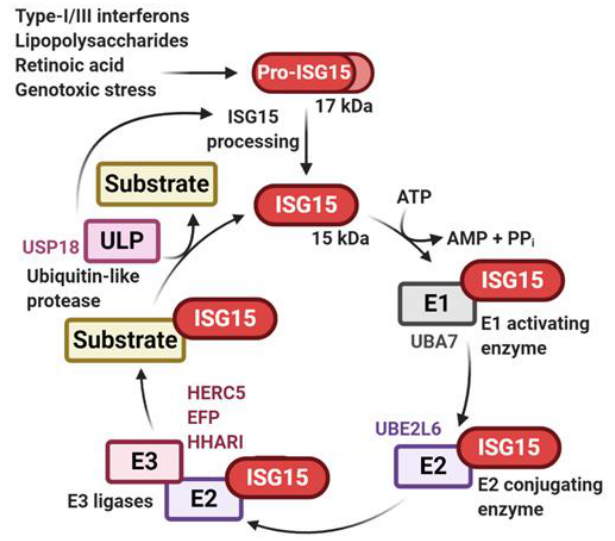
Figure 2. ISG15 conjugation cascade. Expression of ISGylation components is induced by different stimuli as indicated. After processing into its mature form, ISG15 can be conjugated to proteins via a three-step enzymatic cascade comprised of UBA7 (aka UBE1L) as the E1 activating enzyme, UBE2L6 (aka UBCH8) as the E2 conjugating enzyme and either HERC5, EFP (aka TRIM25) or HHARI (aka ARIH1) as the E3 ligase (note that these ligases are diverse in nature encompassing HECT-type, RING-type and HECT-RING hybrid E3 ligases, respectively). The ubiquitin-like protease (ULP) USP18 (aka UBP43) acts as an ISG15-specific protease, cleaving ISG15 from substrates and processing pro-ISG15 into its mature form. Figure created using BioRender.com (2020).